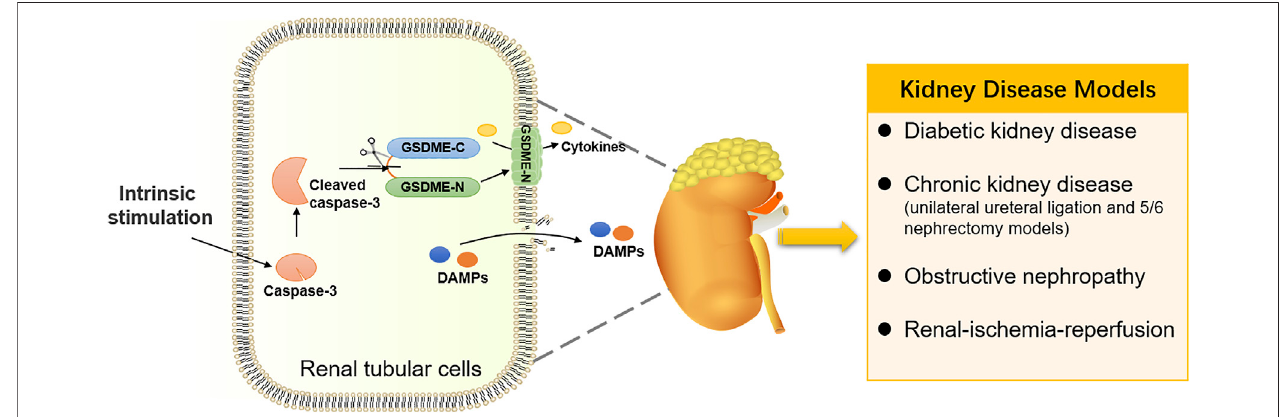
FIGURE 4 | GSDME-mediated pyroptosis in kidney diseases. Intrinsic stimulation drives GSDME-mediated pyroptosis in renal tubular cells, participating in the occurrence and development of kidney